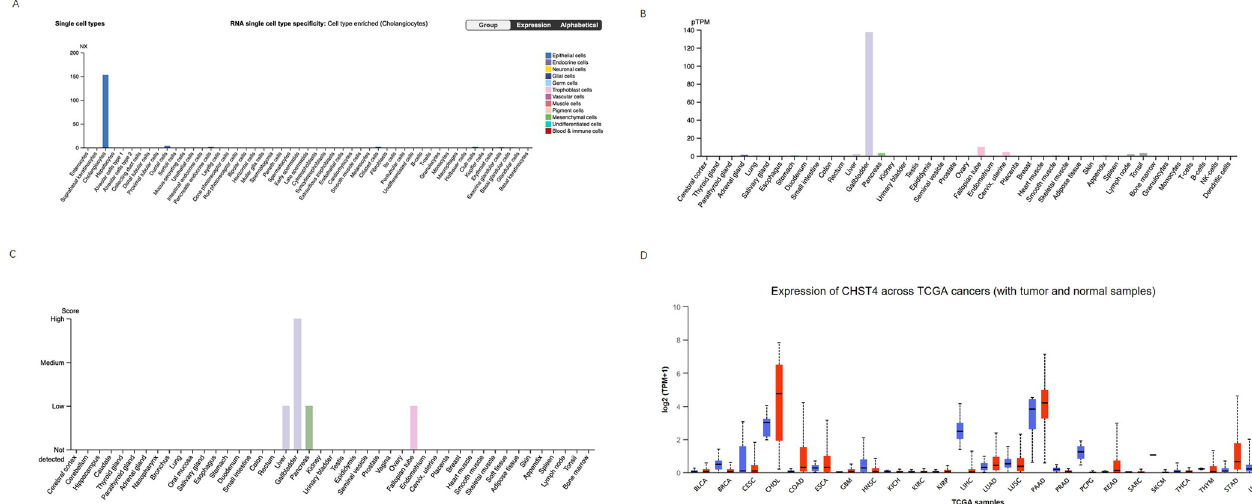
Fig 7. CHST4 expression in normal tissues and various tumors. (A) expression of CHST4 in different normal cells, (B) RNA expression of CHST4 in different normal tissues, (C) protein expression of CHST4 in different normal tissues, (D) expression of CHST4 between tumor and normal samples in TCGA (Red: tumor sample, blue: normal